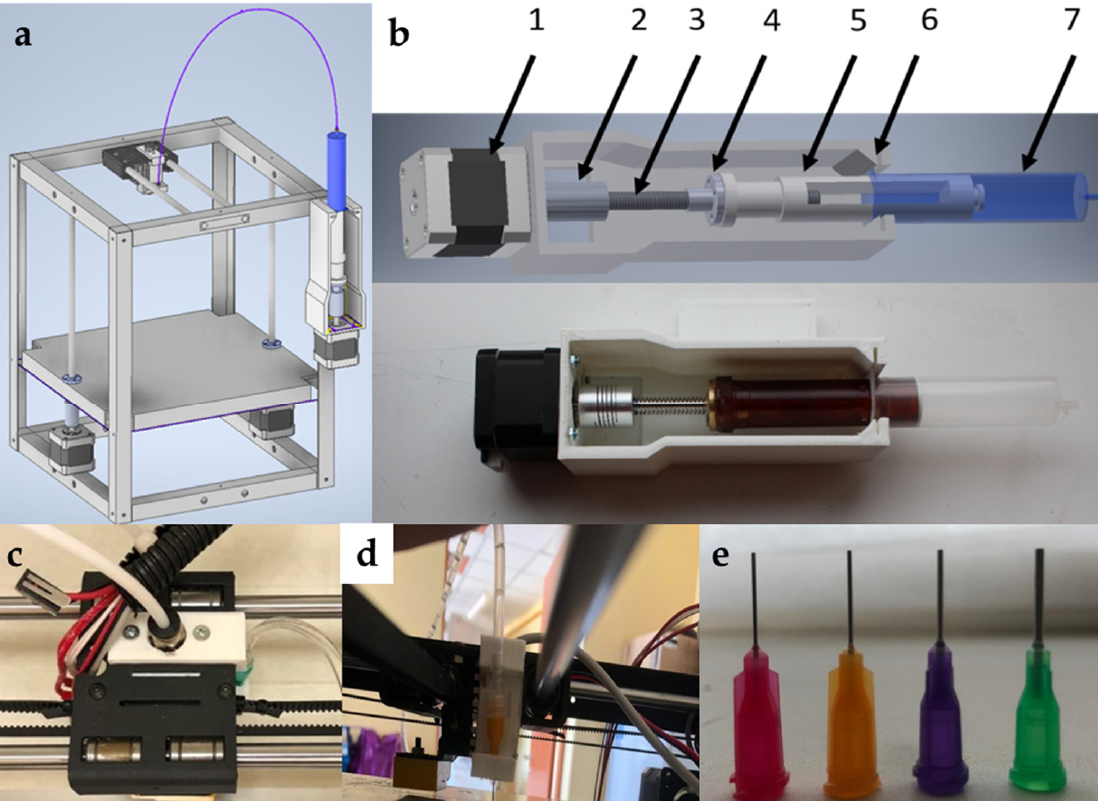
Figure 9. Demonstration of the printed structures. ( a ) Construction of the 3D printer for the gel-like materials; ( b ) punching device for the gel-like materials: 1—stepper motor; 2—coupling; 3—trapezoidal nut; 4—trapezoidal screw; 5—piston; 6—holder; 7—container with material; ( c ) top view of the extruder nozzle holder; ( d ) side view of the extruder nozzle holder; ( e ) extruder nozzle with different diameters.